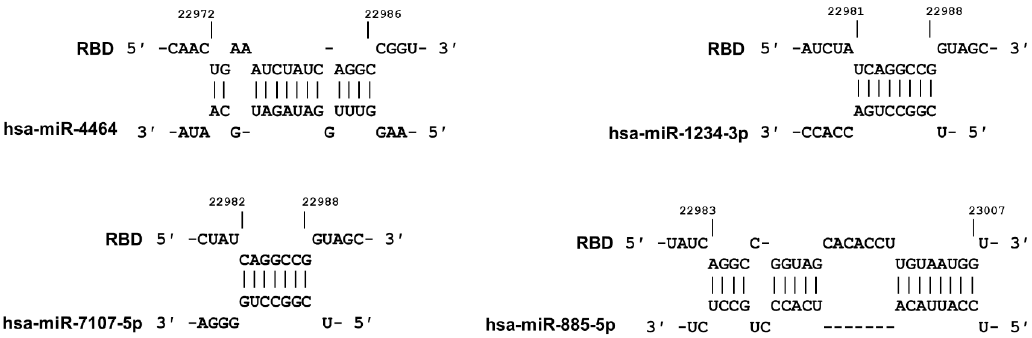
Figure 6. Identification of four miRNAs with ability to bind to the RBD within the S gene. Although not expressed in target cells, these potential miRNAs are included due to their potential use in miRNA-mediated attenuation of the SARS-CoV-2 [37,38] .